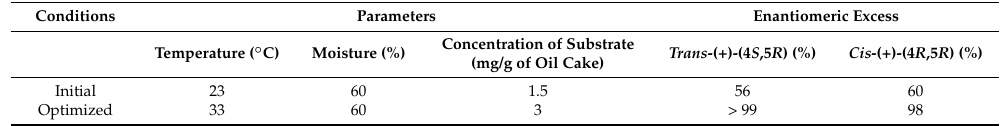
Table 3. The comparison of the enantiomeric purity of whisky lactone isomers obtained before and after optimization of the biotransformation process.